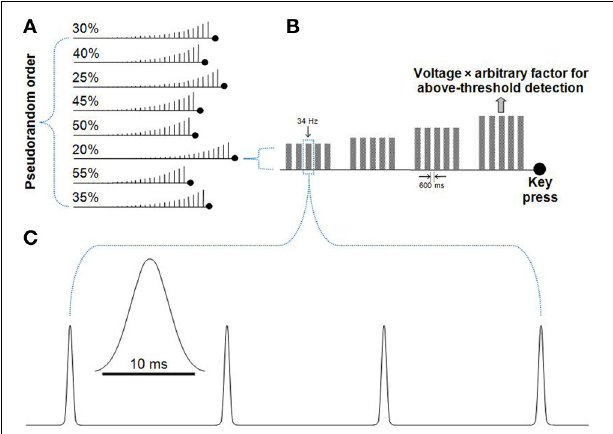
FIGURE 1 | Detection threshold procedure. Participants were presented with trains of Gaussian deflections that gradually increased in set step-sizes until the movement of the probe was detected. (A) A pseudorandom order of runs with voltage increase step-sizes of 20–55% was presented. For each run, the participant was instructed to press a keyboard key when they perceived the movement of the vibrotactile probe. Accuracy rather than speed was emphasized. (B) A series of Gaussian deflections comprised a 34Hz vibration played in a train of five, separated by 600ms. If no button was pressed, the next train would step-up in voltage. After the key was pressed, the driving voltage of the probe was recorded. The average driving voltage from the eight runs shown in (A) was used to derive each participant’s amplitude for the subsequent titration procedure and main task, where a large arbitrary factor (50 for the titration procedure, 30 for the main task) was used to multiply each participant’s voltage value to well-above detection threshold amplitude. (C) The 34Hz Gaussian deflections played for 512ms (17 Gaussian deflections, with the diagram showing four deflections). Each deflection had the form of a truncated Gaussian of 10ms duration (Lak et al.,